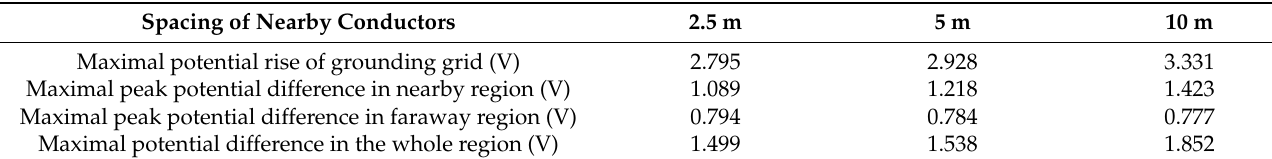
Table 2. Ground potential distribution under different conductor densities.